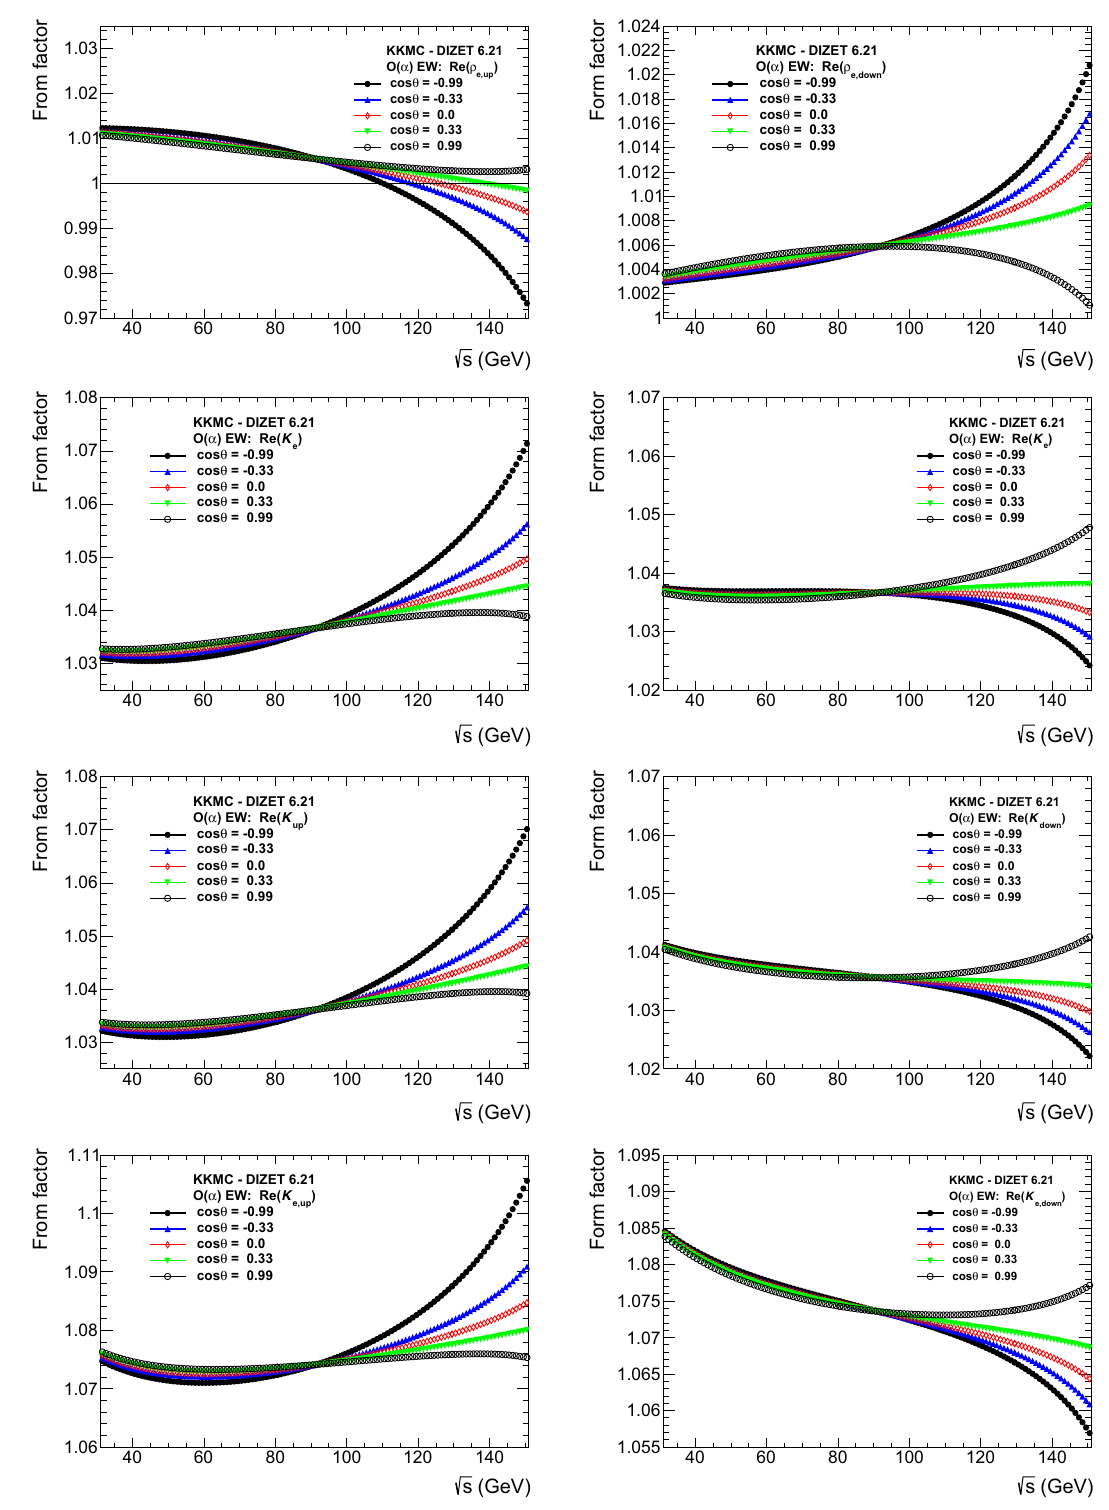
Fig. 1 Real parts of the ρ e , up , K e , K up and K e , up EW form-factors of q ¯ q → Z → ee process, as a function of cos θ . For the up-type quark flavour, left side plots are collected and for the down-type the right side plots. Note, that K e depends on the flavour